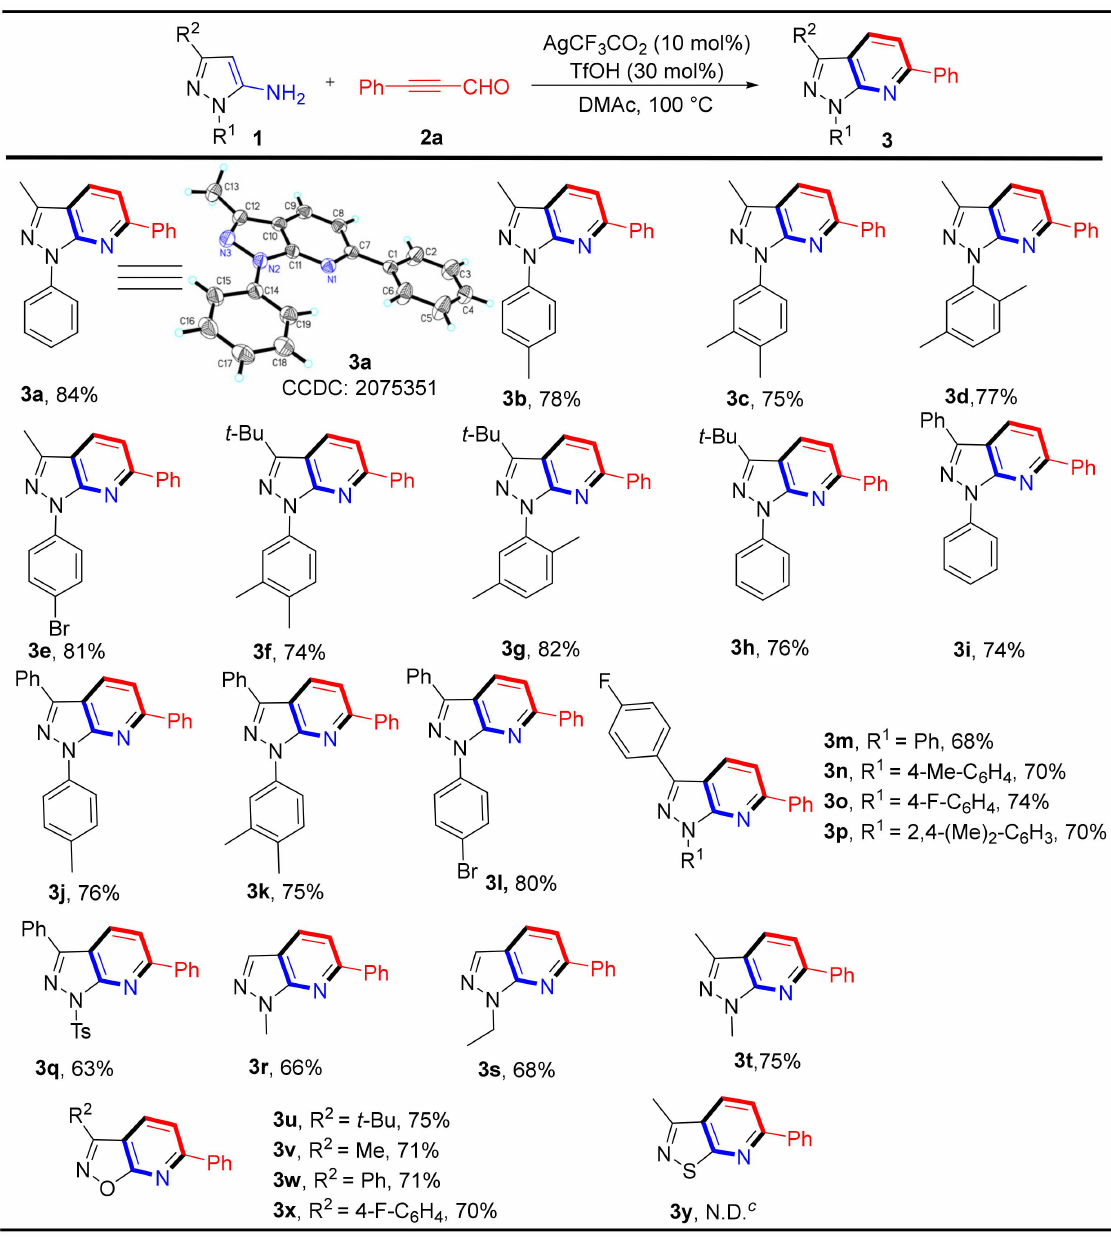
Scheme 2. Substrate scope and Isolated yield of substituted 5-aminopyrazoles and